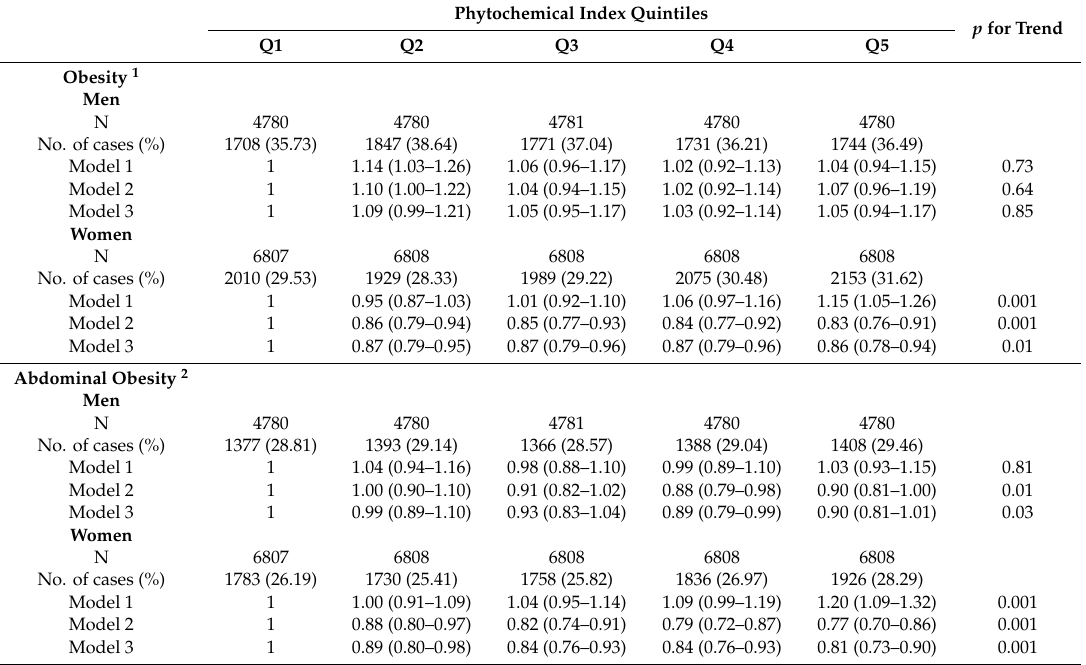
Table 2. Odds ratios (95% confidence intervals) for obesity and abdominal obesity according to the phytochemical index